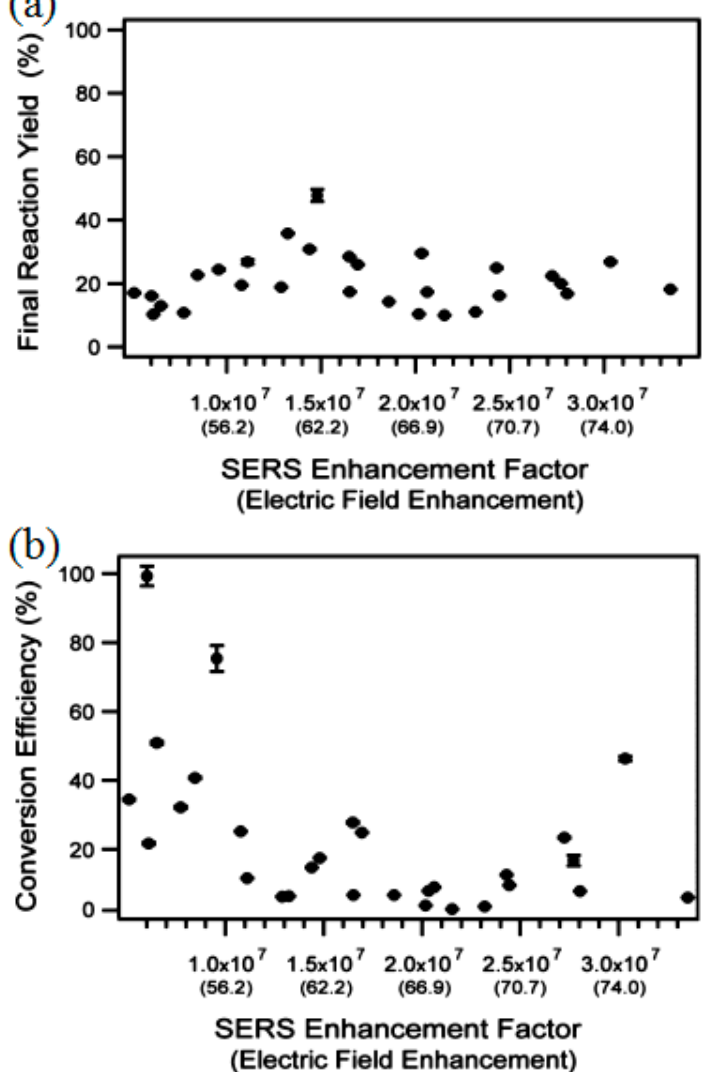
Figure 9. ( a ) Final reaction yield, which is the ratio between product final amplitudes and reactant amplitudes of photoreactions and dependence on SERS EF. As localized field enhancement increased, the reaction yield stayed between 10% and 40%; ( b ) dependence of conversion efficiency, defined as the ratio between the amplitude changes of the product and reactant amplitudes on the SERS EF. As field enhancement increased, the reactant peak (1338 cm − 1 ) decayed more significantly than the product peak formed (1434 cm − 1 ) [45].